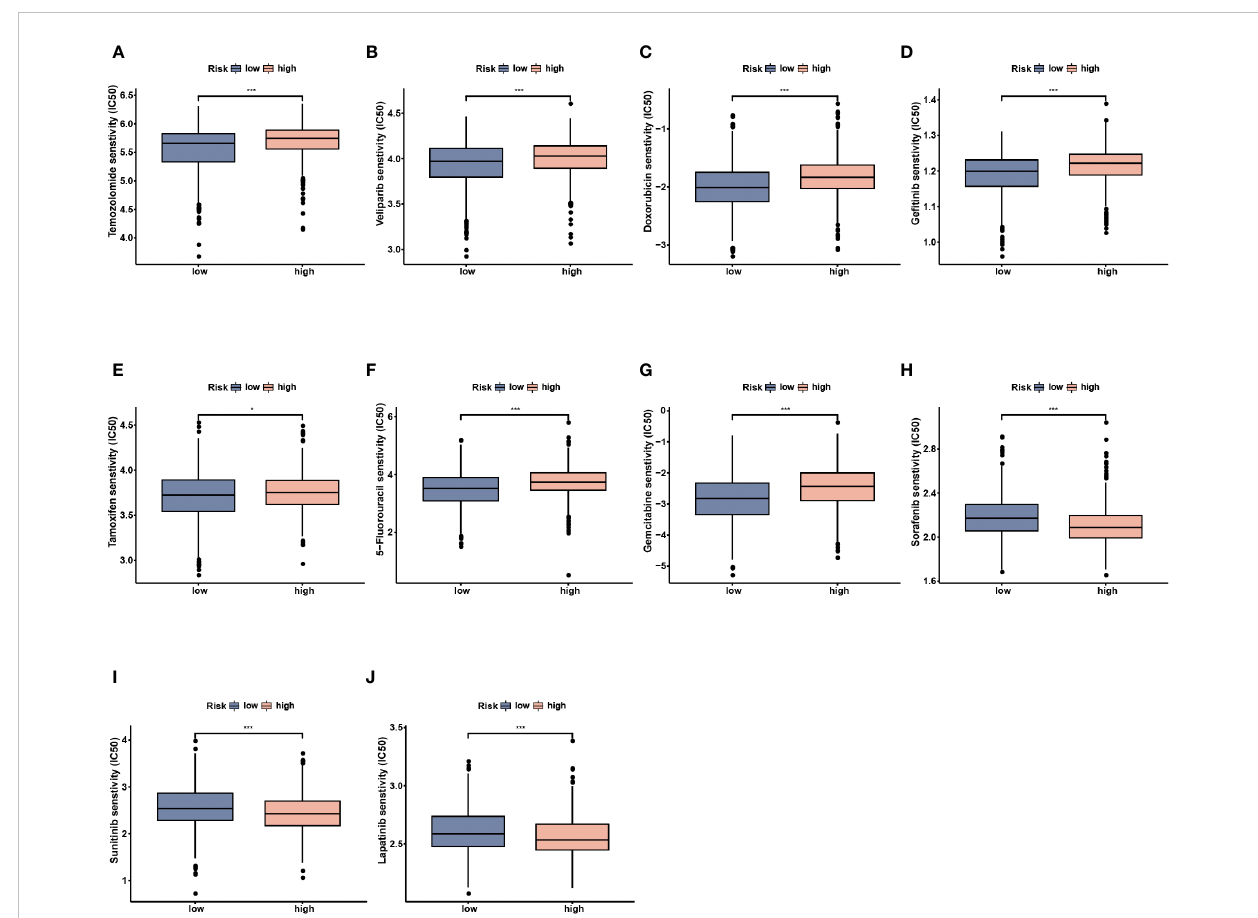
FIGURE 10 Drug sensitivity analysis between the low- and high-risk groups. (A) Temozolomide. (B) Veliparib. (C) Doxorubicin. (D) Ge fi tinib. (E) Tamoxifen. (F) 5-Fluorouracil. (G) Gemcitabine. (H) Sorafenib. (I) Sunitinib. (J) Lapatinib. * p<0.05, ***